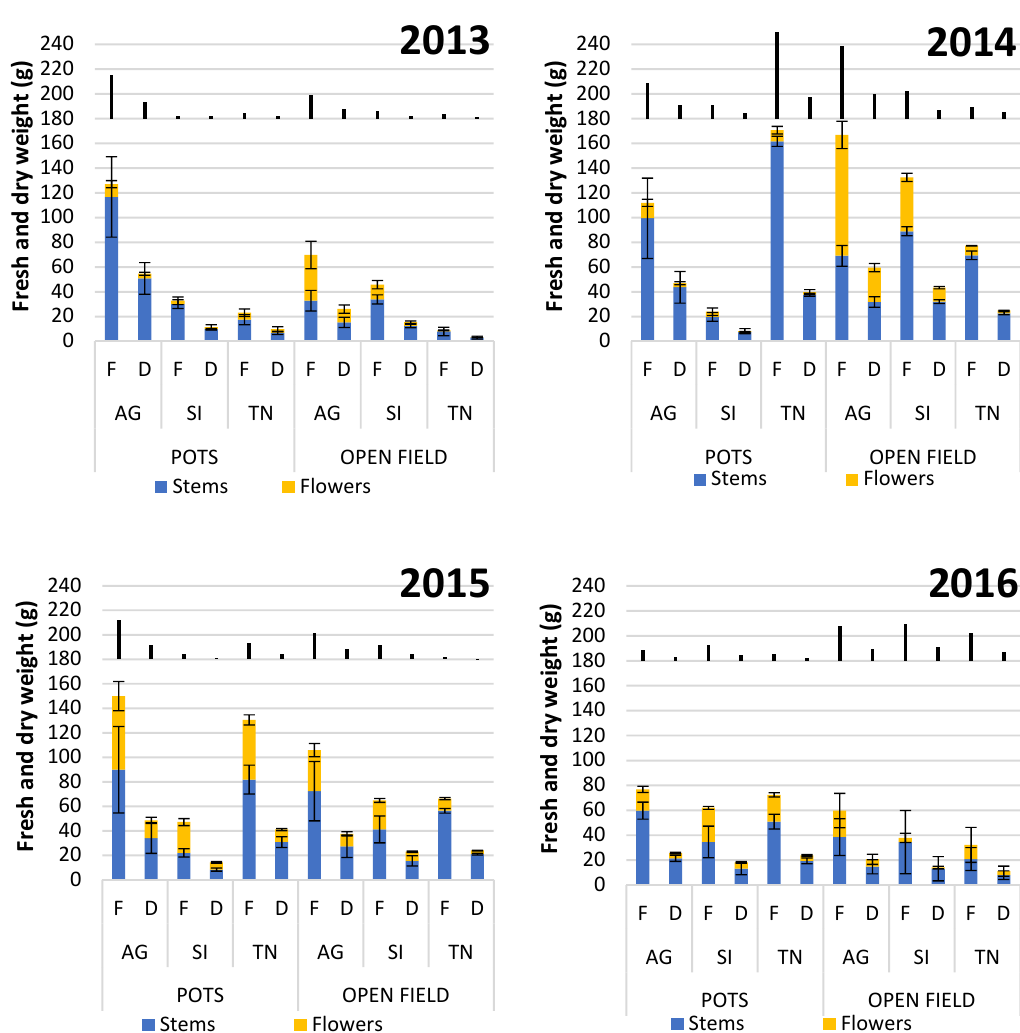
Figure 3. Fresh (F) and dry (D) weight of flowers (yellow) and stems (blue) in 3 H. perforatum biotypes cultivated from 2014 to 2016 in two management systems. Error bars represent the standard deviations of each mean. Vertical bars in the upper part of each graph indicate the standard deviations of the total aerial mass (flowers + stems) per plant.